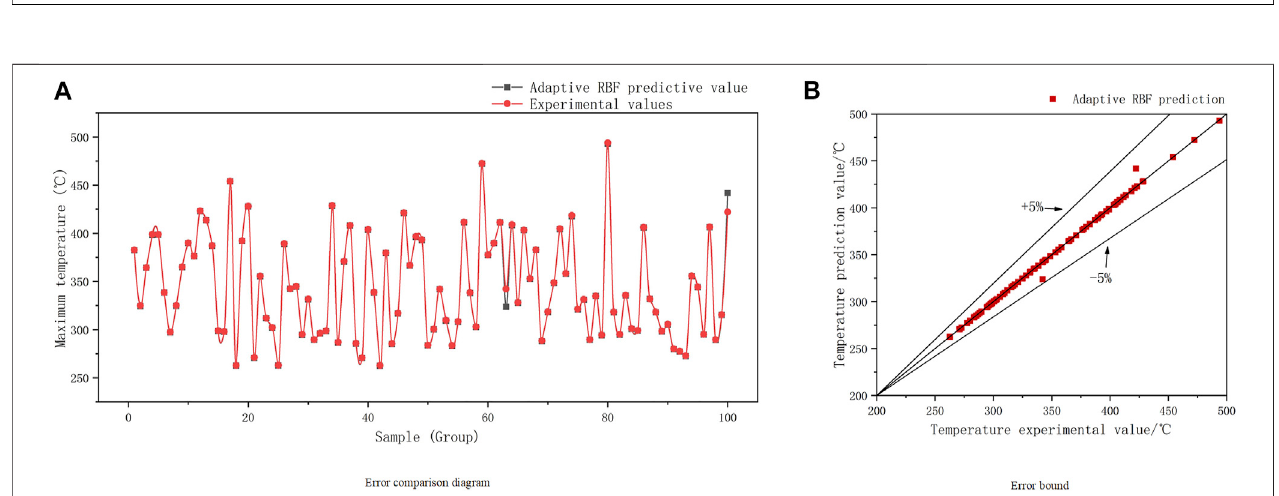
FIGURE 5 | The error comparison diagram and the error bound of adaptive BP neural network.